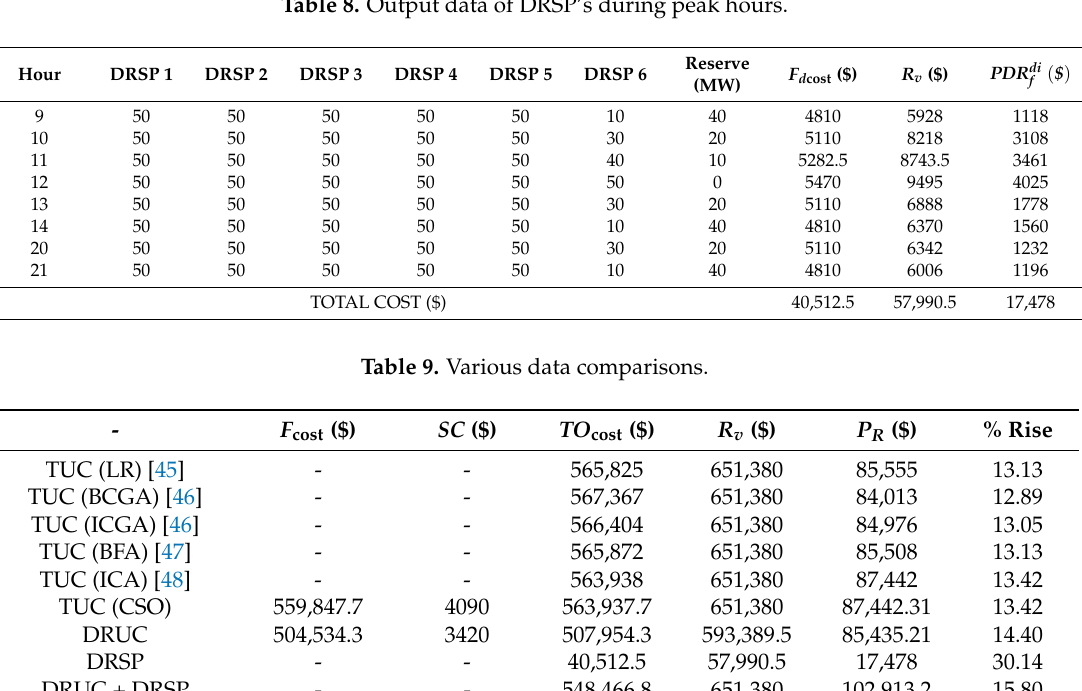
Table 8. Output data of DRSP’s during peak hours.